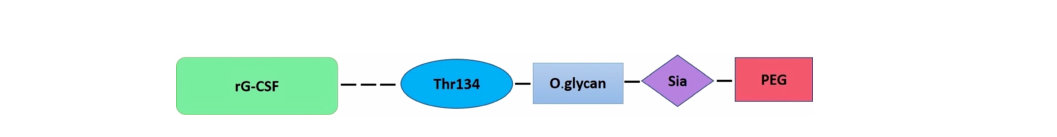
FIGURE 4 Plan structures of lipeg fi lgrastim. Conjugation of a single 20-kDa PEG – sialic acid (Sia) to a natural O -linked glycan moiety bound at the Thr-134 residue site of